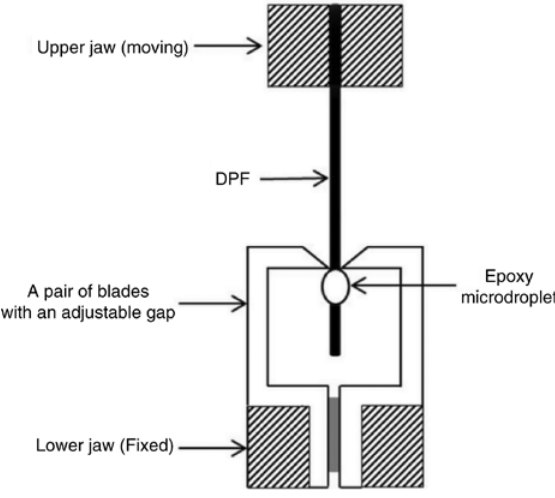
Figure 4: Schematic diagram of the microbond